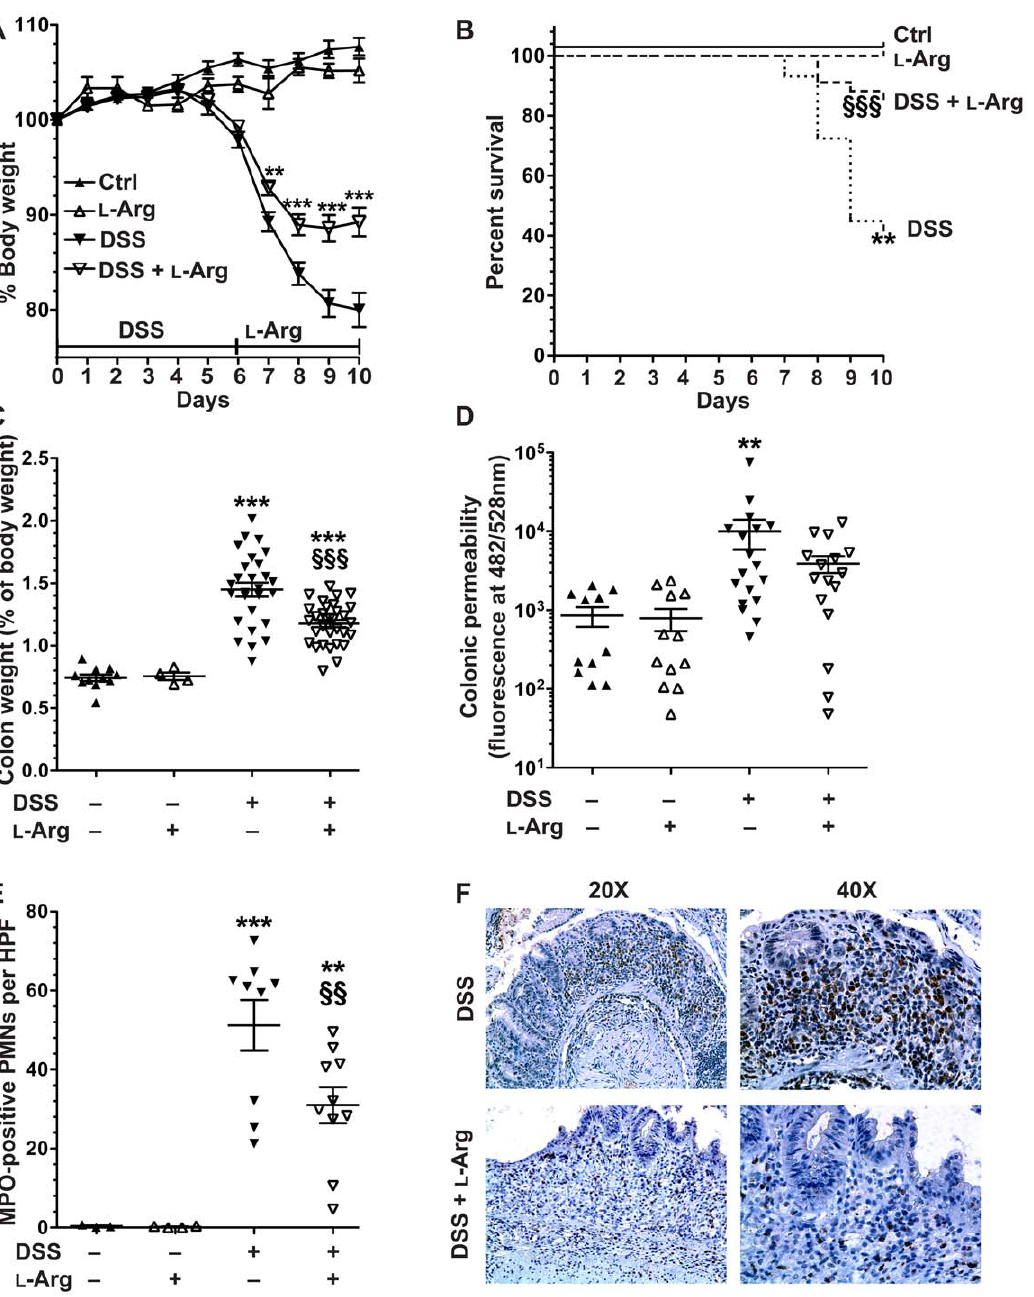
Figure 4. L-arginine improves clinical parameters, mucosal integrity, and PMN inflammatory cell infiltration in DSS-induced colitis. 7-week-old C57BL/6 mice received 4% DSS in the drinking water or water alone (Ctrl) for 6 days, followed by administration of 1% L-Arg in the drinking water, or water alone for 4 days. (A) Body weights of the mice were measured daily and presented as a percentage of their initial body weight. ** p , 0.01, *** p , 0.001 vs. DSS. (B) Survival analysis, with mortality based on . 20% body weight loss. ** p , 0.01 vs. Ctrl. 111 p , 0.001 vs. DSS. (C) At sacrifice, colons were removed, cleaned, and weighed. The fresh colon weight was determined as a percentage of the total body weight. *** p , 0.001 vs. control and 111 p , 0.001 vs. DSS. In A–C, n =4–11 for controls, n =27–32 for treatments. (D) Prior to sacrifice, mice were anesthetized and given FITC-labeled dextran via rectum. Blood was obtained by cardiac puncture at 2 h. Fluorescence was measured in the serum at 482 nm and 528 nm. In (D), n =4–8 for controls, n =14–16 for treatments. ** p , 0.01 vs. control. (E) and (F) At sacrifice, colons were removed, cut open longitudinally, cleaned, Swiss-rolled and formalin fixed for future staining with MPO antibody. (E) The number of MPO-positive PMNs per HPF were counted. 20 HPFs per slide were assessed. (F) Representative photomicrographs of MPO staining after DSS treatment alone or DSS followed by L-Arg supplementation. n =4 for controls, n =9–10 for treatments. ** p , 0.01, *** p , 0.001 vs. control. 11 p , 0.01 vs. DSS.